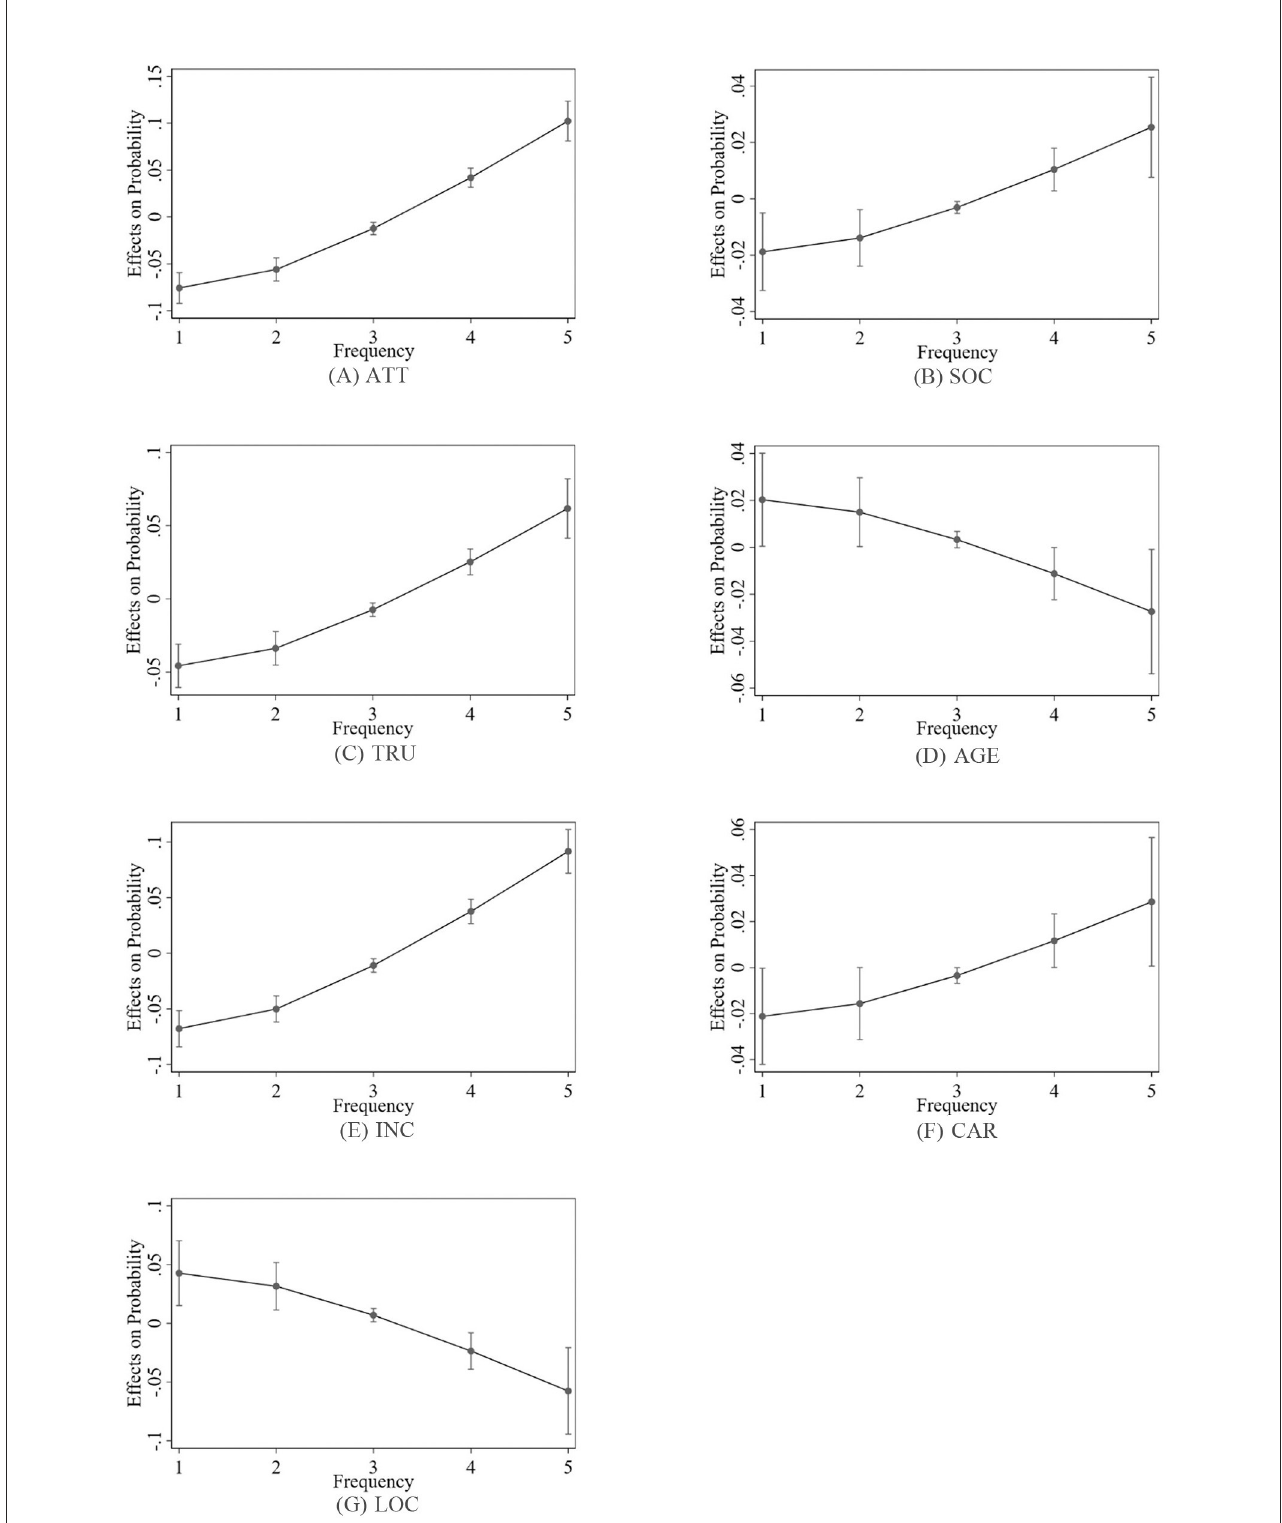
FIGURE3 Average marginal effects at 95% confidence intervals before the